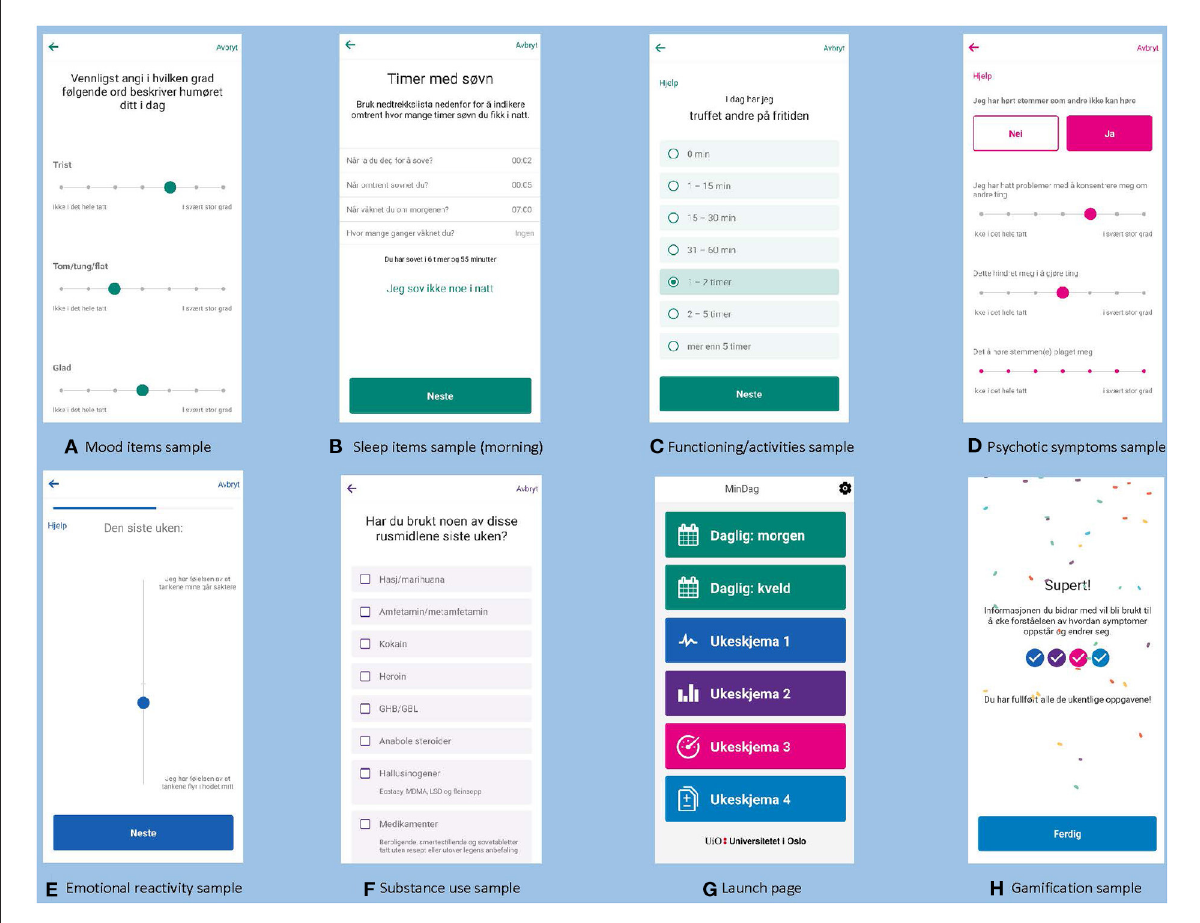
FIGURE3 Screenshots from MinDag